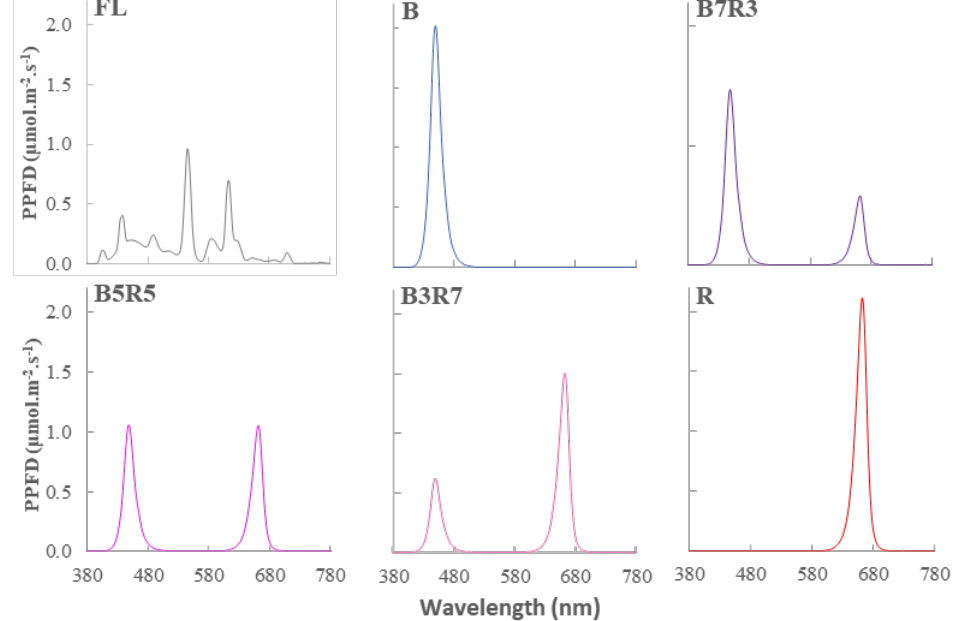
Figure 2. The spectra of photosynthesis photon flux densities of light treatments used in this study. All light treatments were at the same PPFD of 50 μmol ·m − 2 ·s − 1 .